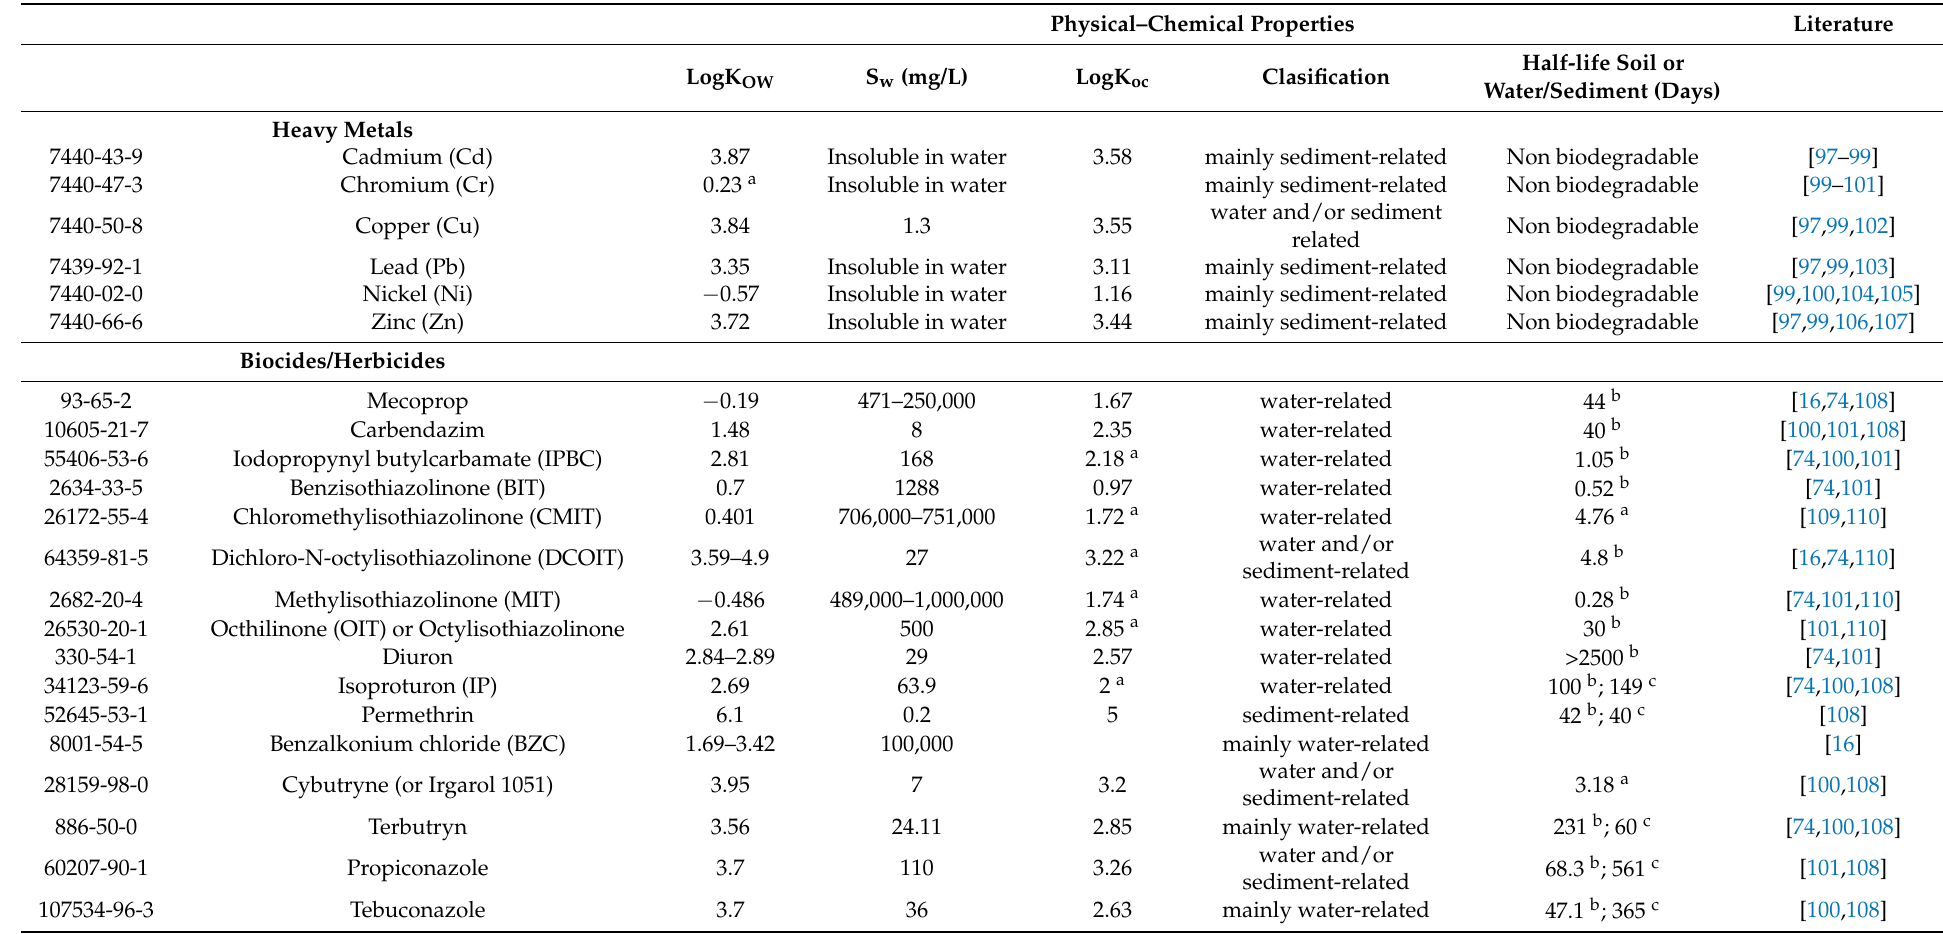
Table 3. Pollutants emitted from green roofs and vertical greenery systems and their physical–chemical